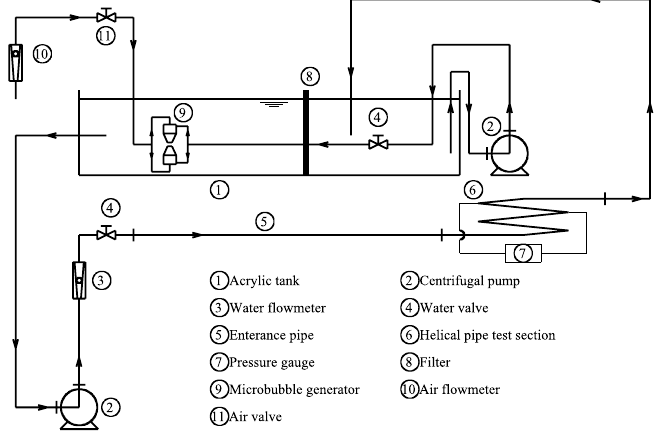
Fig. 3 Schematic representation of the experimental